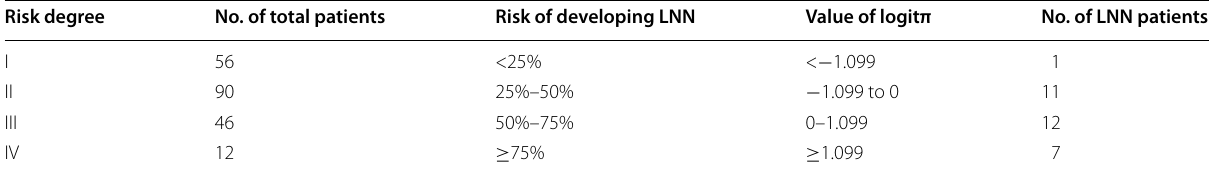
Table 3 The risk of developing LNN according to the model